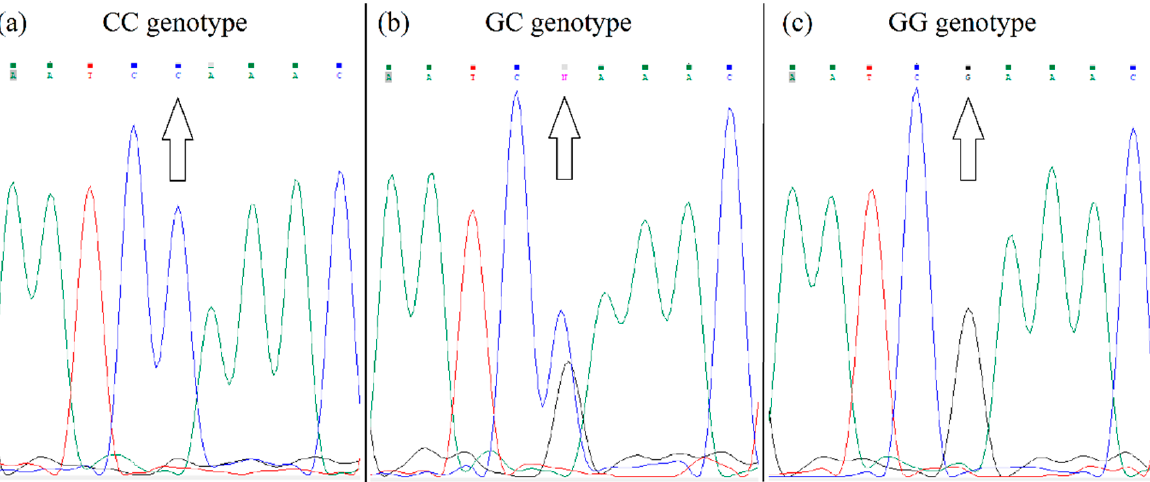
Figure 3. Fluorogram of PPARA gene sequencing. Figure ( a ) shows the CC genotype, since the polymorphic site contains the nucleotide C. Figure ( b ) shows the GC genotype, because the polymorphic site contains both G and C nucleotides. Figure ( c ) shows the GG genotype, since nucleotide G is located at the polymorphic site.